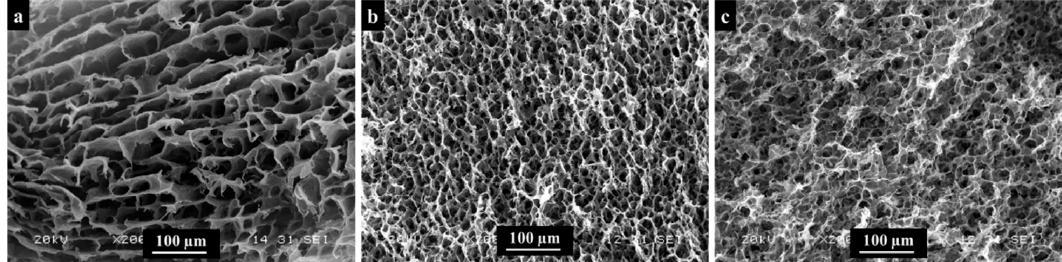
Figure 3. SEM images of aerogels prepared from cellulose-stabilized emulsions at different concentrations: ( a ) 1 wt %, ( b ) 2 wt %, and ( c ) 3 wt %. Reprinted with permission from [26]. Copyright 2018 American Chemical Society.